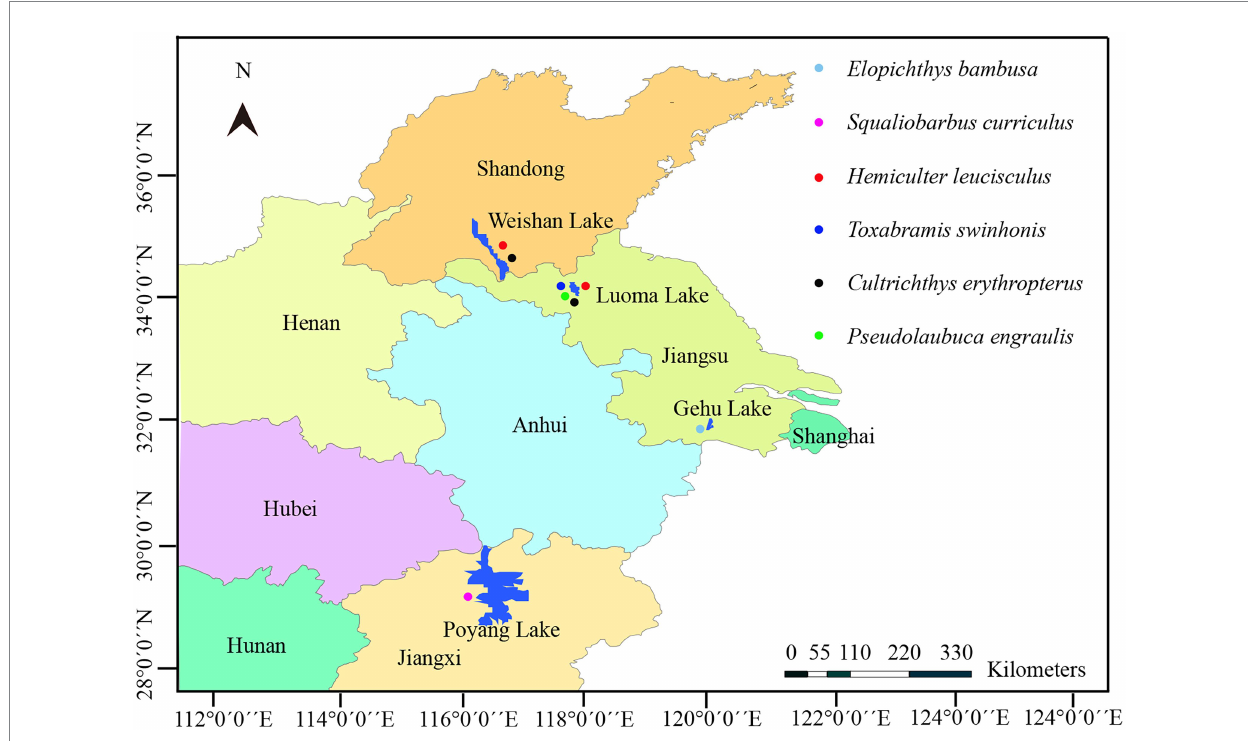
FIGURE 1 A map of part of Eastern China shows the sampling sites of six species of